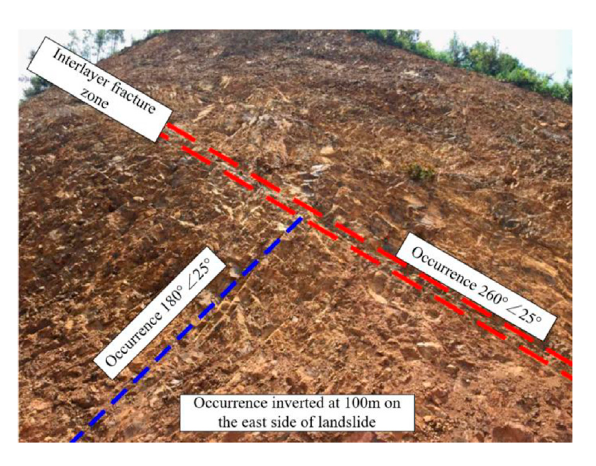
FIGURE 7 Occurrence and interlayer fracture zone on the east side of the landslide